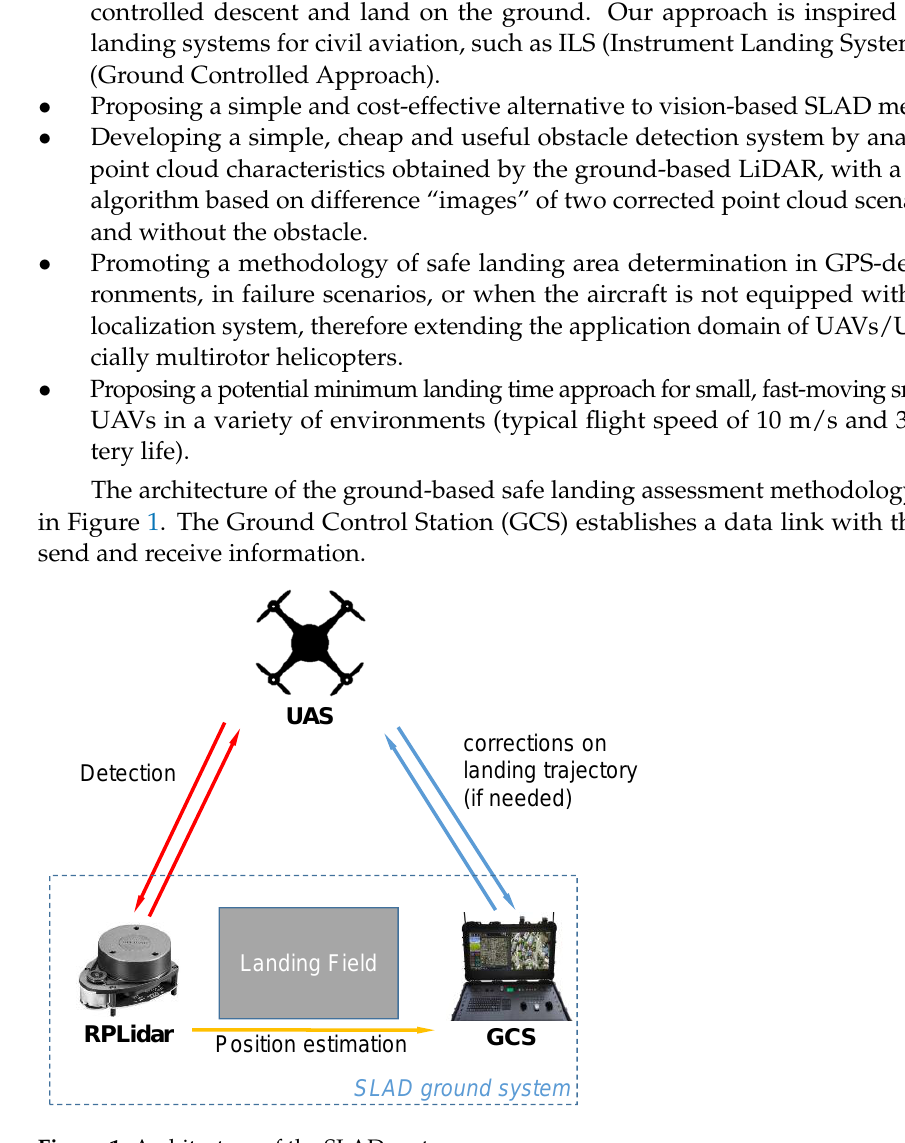
Figure 1. Architecture of the SLAD system.